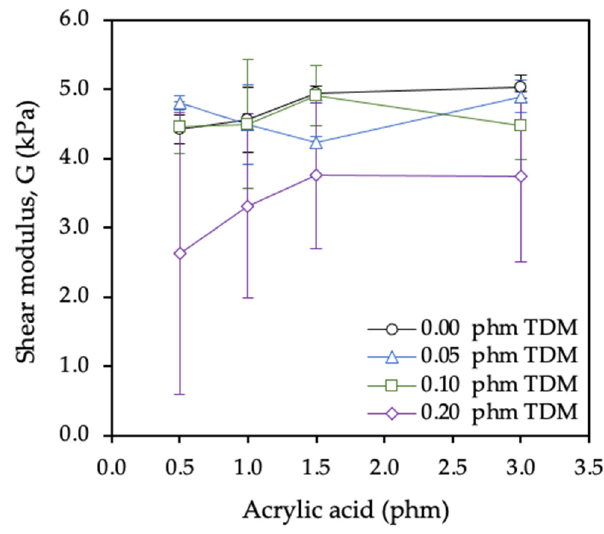
Figure 9. Effect of acrylic acid and tert-dodecyl mercaptan (TDM) contents on the shear modulus.